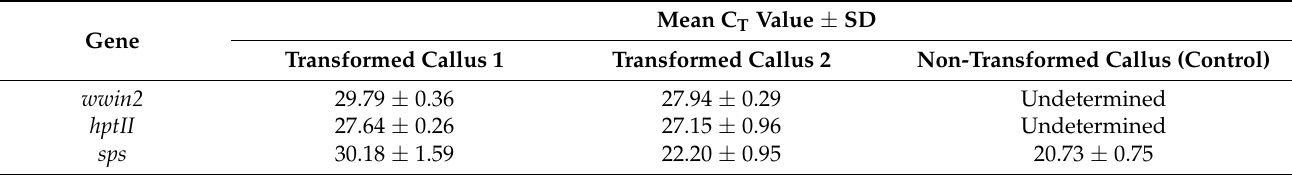
Each value represents the mean ± standard deviation (SD) in 3